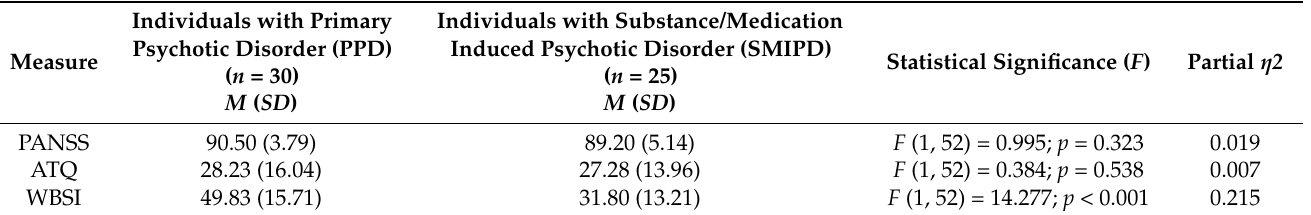
Table 2. Descriptive Statistics for Psychosis Severity, Suppression, and Automatic